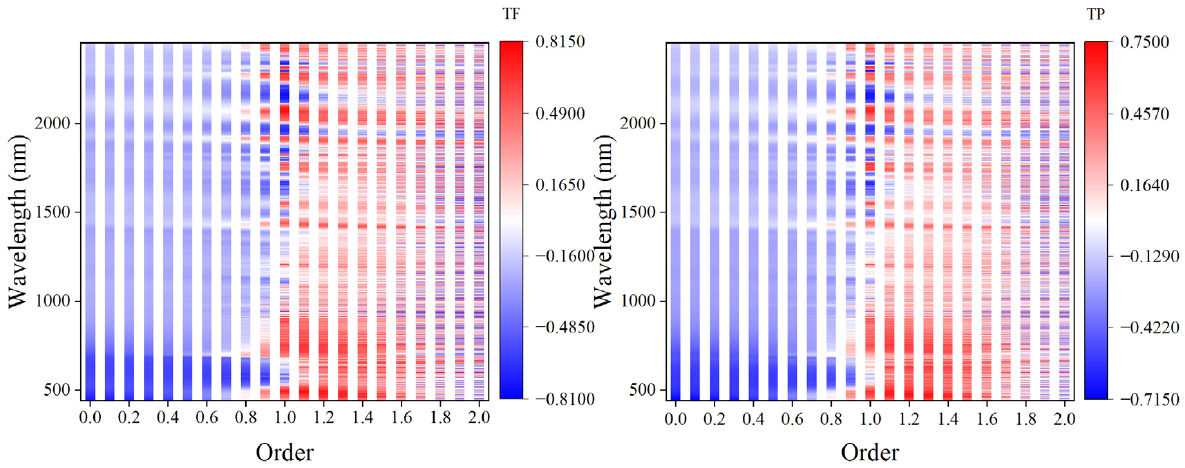
Figure 5. Correlation between FOD spectra and total fl avonoids and total phenols in grains.